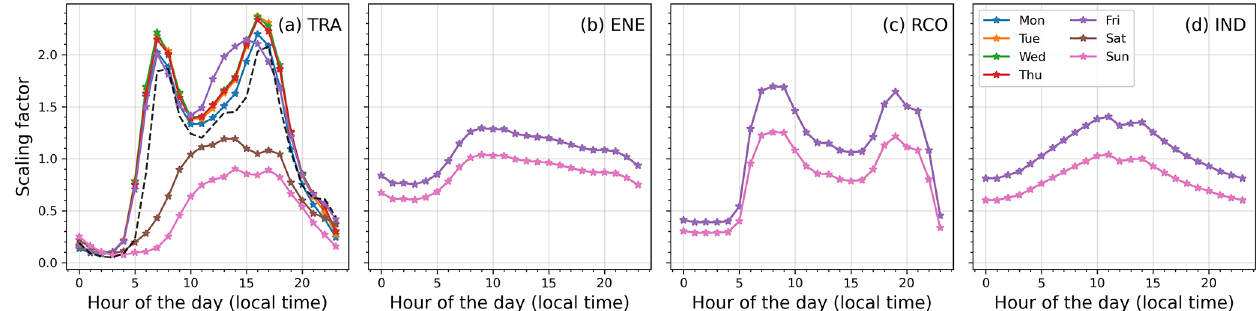
Figure A1. Temporal profiles of NO x emissions from various sectors. “TRA”: road transport, “ENE”: energy generation, “RCO”: residential and non-industrial combustion, “IND”: industries. For TRA, lines and markers correspond to the profiles derived using actual vehicle count, while for others profiles are derived according to the recommendation of Schaap et al. (2005). For TRA, the recommendations of Schaap et al. (2005) are shown as the dashed line in panel (a)